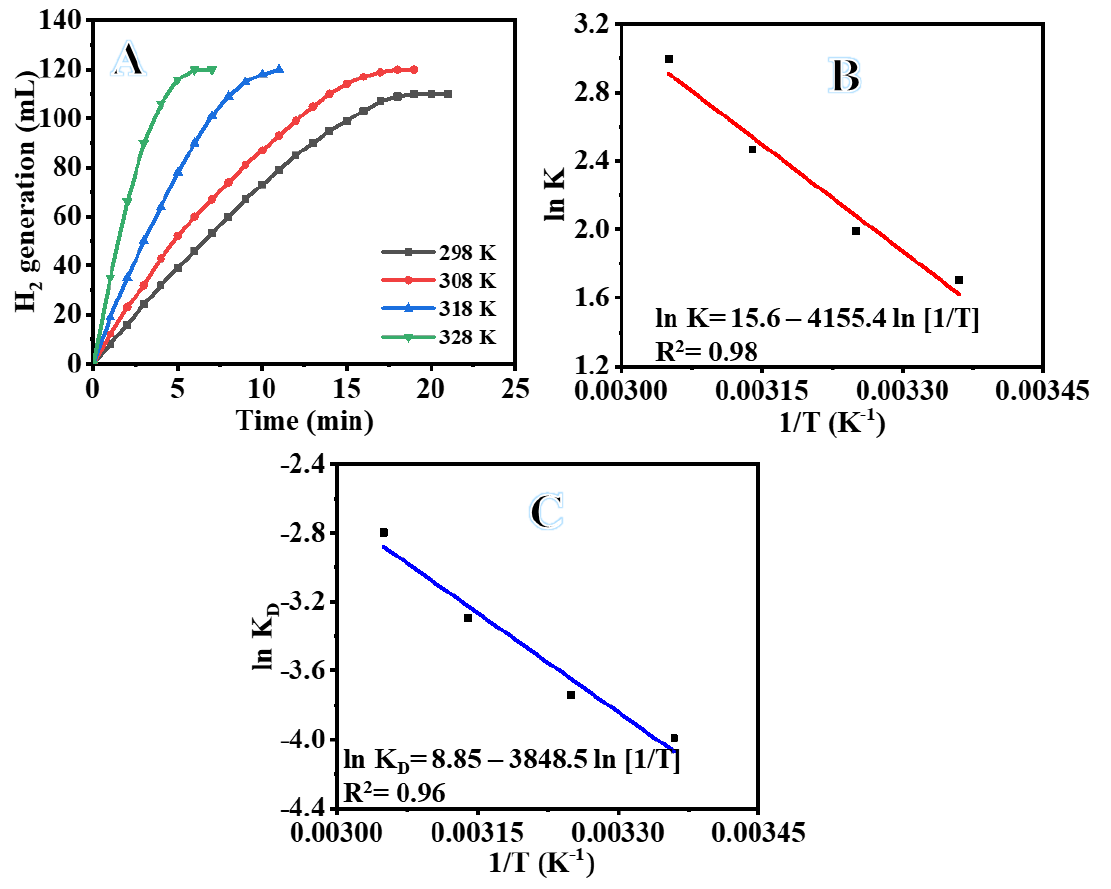
Figure 10. The influence of temperature on dehydrogenation of SBH ( A ), ln K vs. (1/T) ( B ), and ln K D vs. (1/T) ( C ). The amount of catalyst = 100 mg and [SBH] = 1 mmol. The linear portion of temperature graphs is used to calculate the rate (k). Figure 10B shows an Arrhenius plot of ln (K) versus 1/T. As seen in Figure 10B and the Arrhenius equation (Equation (4)), Ea = 35.21 kJ mol-1 was found. The literature reports activation energies for non-noble metals ranging from 16.28 to 42.45 kJ mol −1 [73–77]. The obtained E a value was compared with the E a values of various Co-based catalysts and catalysts supported on polymer substrate. Some examples of these catalysts that can be found in the literature include Co-Ni/AC (68.84 kJ mol −1 ) [78], Ni- PVF capsules (49.3 kJ mol −1 ) [53], Ni-PVF hollow fiber (55.3 kJ mol − 1 ) [41], ([C6(mpy) 2 ][NiCl 4 ] 2- (56.36 kJ mol −1 ) [79], PVF- [C6(mpy) 2 ][NiCl 4 ] 2- (44.54 kJ mol −1 ) [25], Co-Ni/MWAC (40.7 kJ mol −1 ) [76], Sm-Ni-Co-P/g- Al 2 O 3 (52.05 kJ mol −1 ) [72], Ni–Co–B (62 kJ mol −1 ) [80], indicating a superior catalytic performance of the introduced Co@PVHF. The catalyst’s suitability for practical use is largely dependent on its reusability and stability. After the reaction, the Co@ PVHF catalysts may be separated simply by withdrawing the MNFs from the catalytic system. Separation as easy as that has a lot going for it. Without separating or activating the catalyst, SBH may be refilled into the reaction solution (1 mmol of SBH at 25 °C) (100 mg PVHF-40). For this reason, several cycles of SBH hydrolysis were performed to look into PVHF-40s for recycling. As the number of cycles rises, slight declines are seen (Figure 11). However, the same volume of H 2 was generated by extending the reaction time. This may be because, when the membrane is reused without cleaning among cycles, reaction products precipitate out onto its surface, blocking the metal active sites and slowing down hydrogen production.